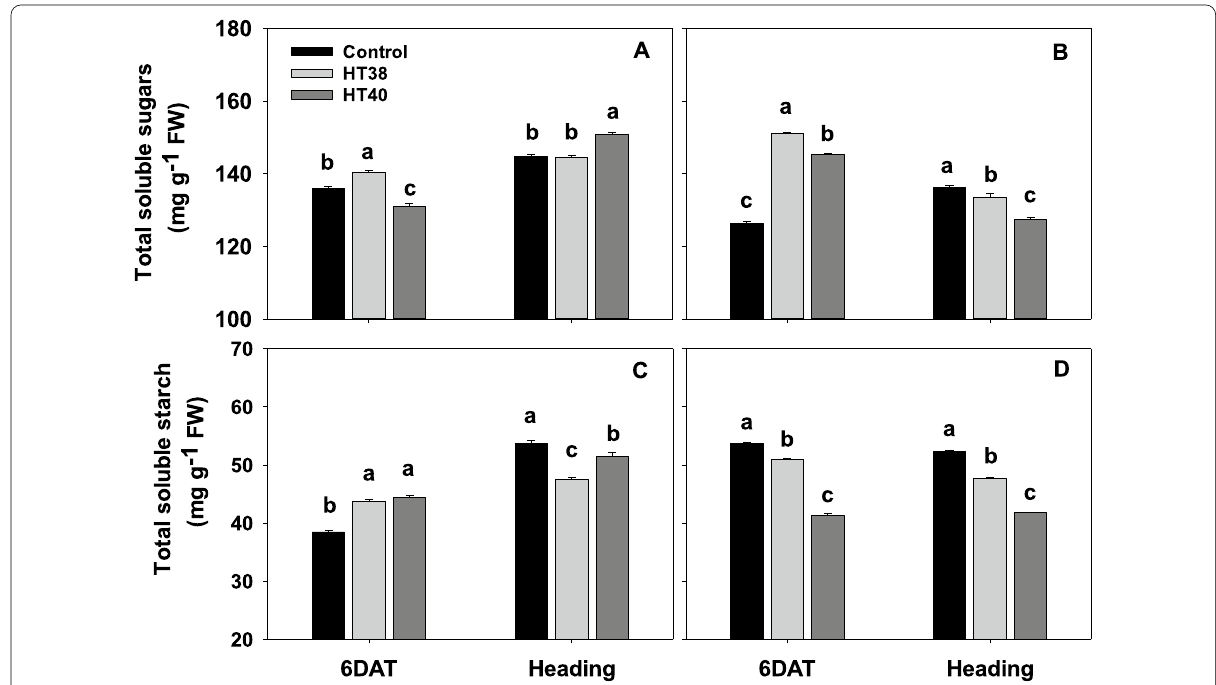
Fig. 5 Total soluble sugars and starch in pistils of N22 ( A and C ) and IR64 ( B and D ) plants at six days of control (30 °C) and heat stress (38 °C— HT38; 40 °C—HT40) exposure during gametogenesis and recovery at heading. Bars with common letter are not significantly different between temperature treatments in a genotype at P 0.05. 6DAT ‑ 6 days after ≤